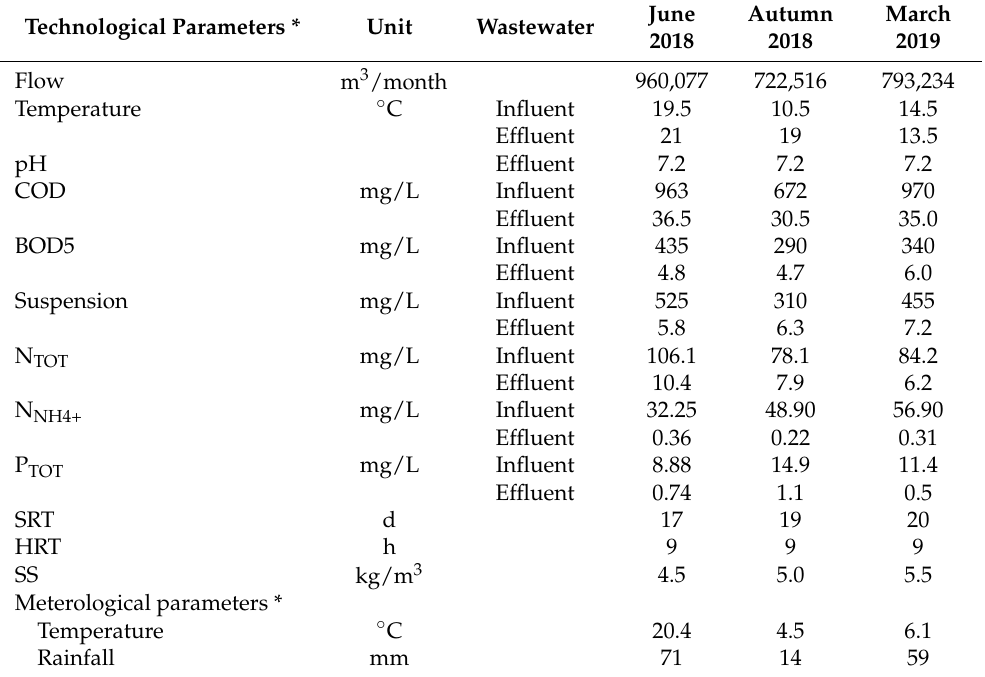
Table 2. Some technological parameters of wastewater treatment plant and meteorological indicators. Technological Parameters *